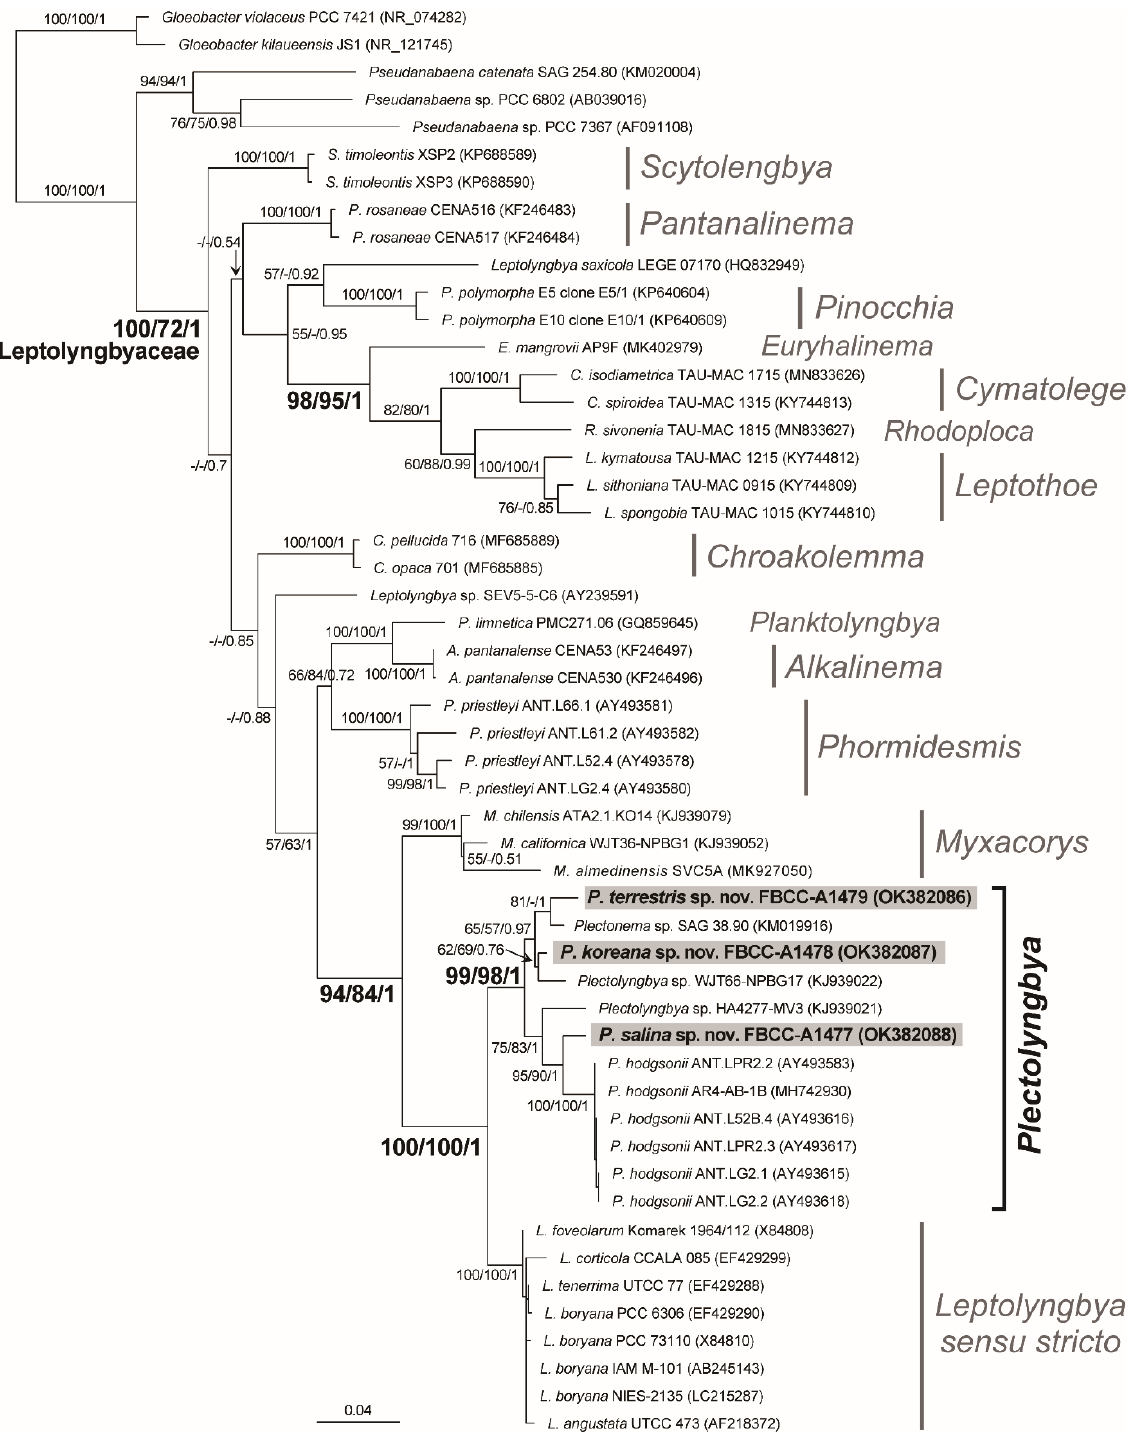
Figure 8. Maximum likelihood (ML) phylogeny of the Plectolyngbya based on 16S rRNA sequences (1435 positions). The best tree of Leptolyngbyaceae (Synechococcales; total 47 strains 14 genus) inferred using RAxML with the GTR + G model. Two Gloeobacter (Gloeobacterales) and three Pseudanabaena (Pseudanabaenaceae, Synechococcales) were selected as the outgroups. The species name followed by strain ID and GenBank accession number within the parentheses. Leptolyngbya sensu stricto adapted from Taton et al. (2011). The ML bootstrap support (MLB), Neighbor-Joining bootstrap support (NJB), and the Bayesian posterior probability (BPP) are given near the monophyletic node, respectively.